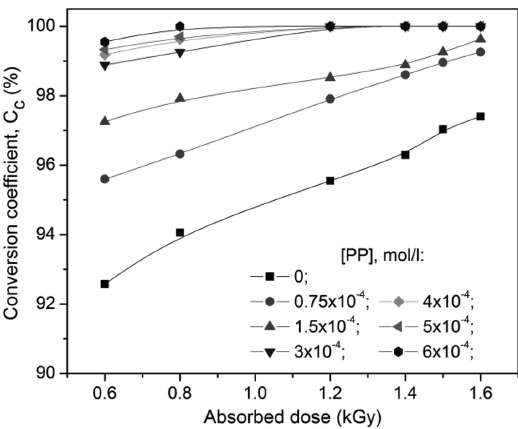
Figure 3. The effect of initiator concentration and EB absorbed dose on intrinsic viscosity (η